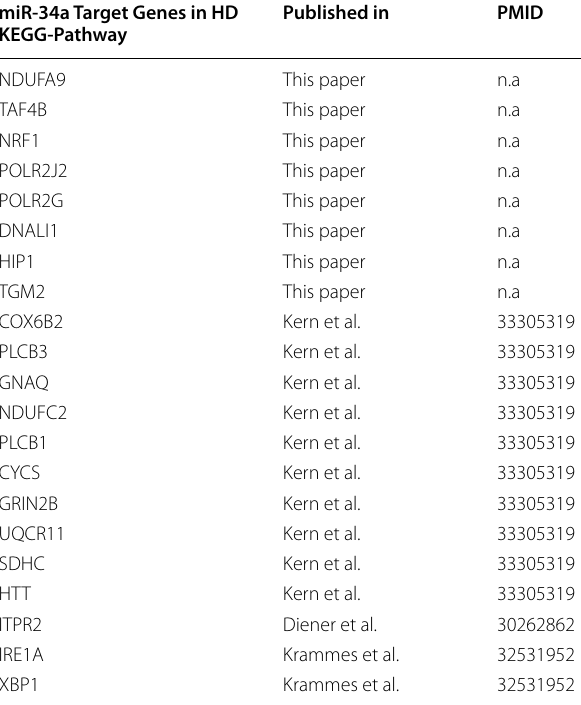
Table 1 Direct targets of miR-34a-5p in KEGG pathway “Huntington’s Disease” miR‑34a Target Genes in HD KEGG‑Pathway